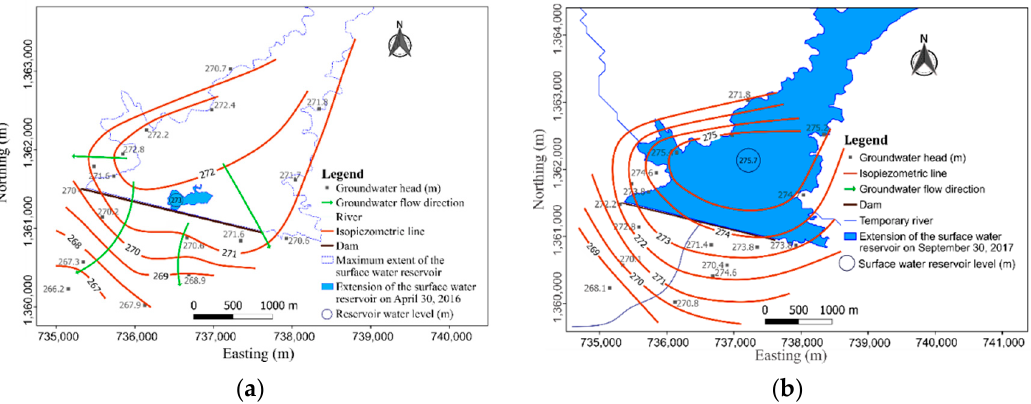
Figure 8. Piezometric map for dry ( a ) and rainy ( b ) seasons within Mogtédo watershed based on measurements from 20 micropiezometers and surface water reservoir (SWR) level.